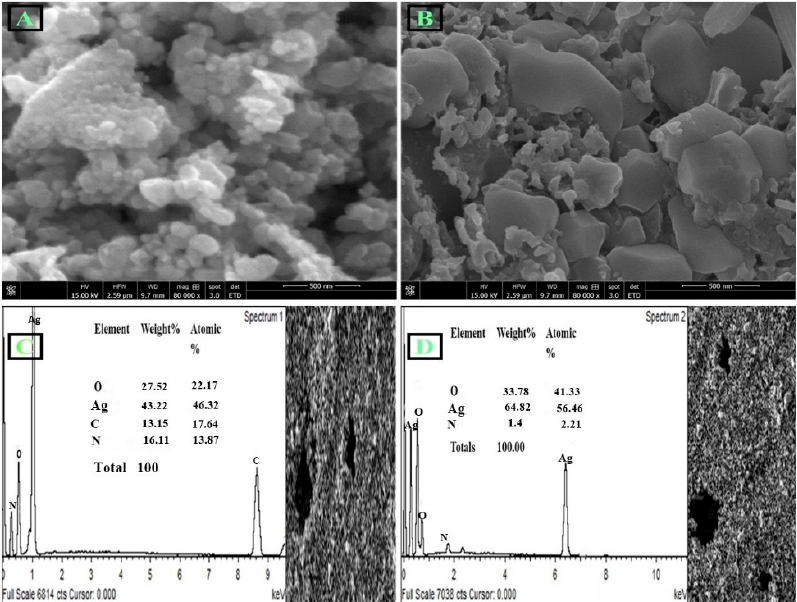
Figure 5. SEM images and EDX spectra of the synthesized AgNPs; ( A ) MS-AgNPs structure, ( B ) bare AgNPs structure, ( C ) MS-AgNP’s EDX spectra, ( D ) bare AgNPs EDX spectra.